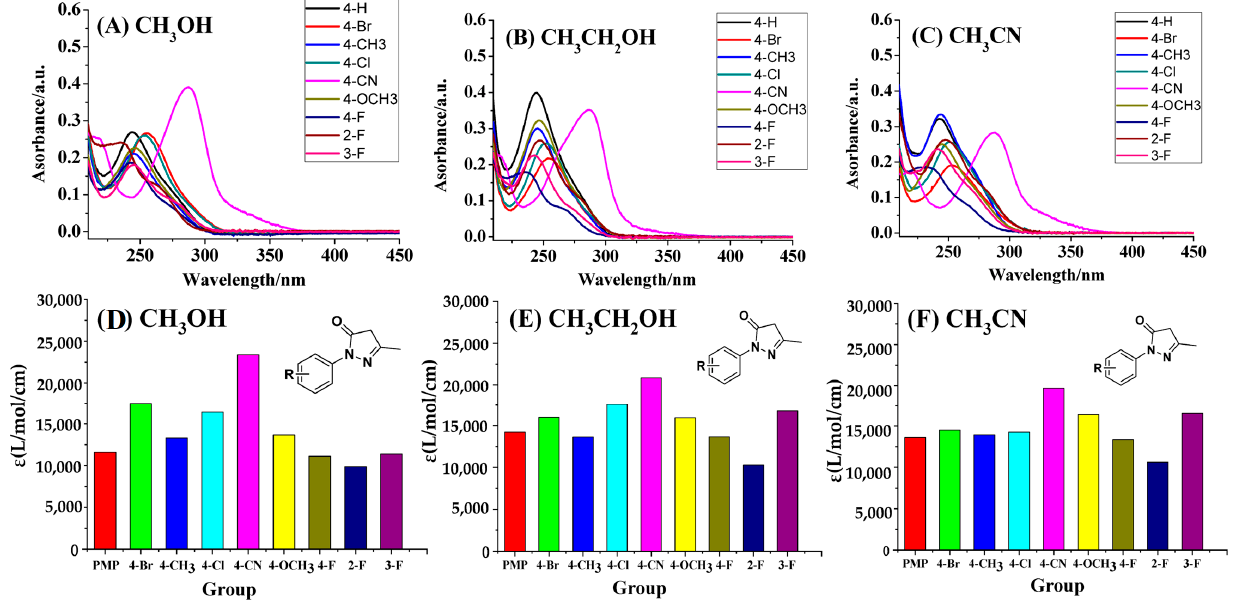
Figure 5. UV absorption spectra and molar extinction coefficients of PMP derivatives with different substituents when methanol ( A , D ), ethanol ( B , E ), and acetonitrile ( C , F ) were used as solvents.